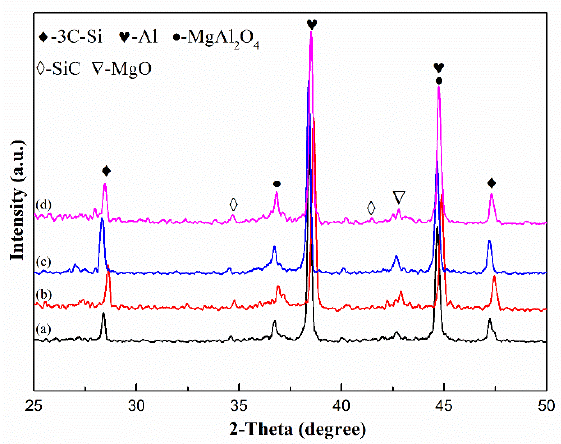
Figure 3. XRD pattern of the composite samples: (a): 0.3%; (b): 0.9%; (c): 1.5%; and (d): 2.1%.